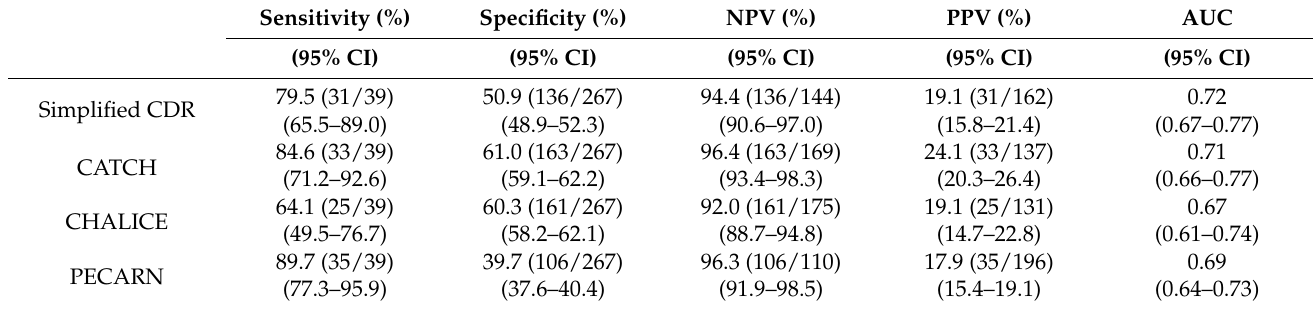
Table 3. Performance of the clinical decision rules for clinically important traumatic brain injury.